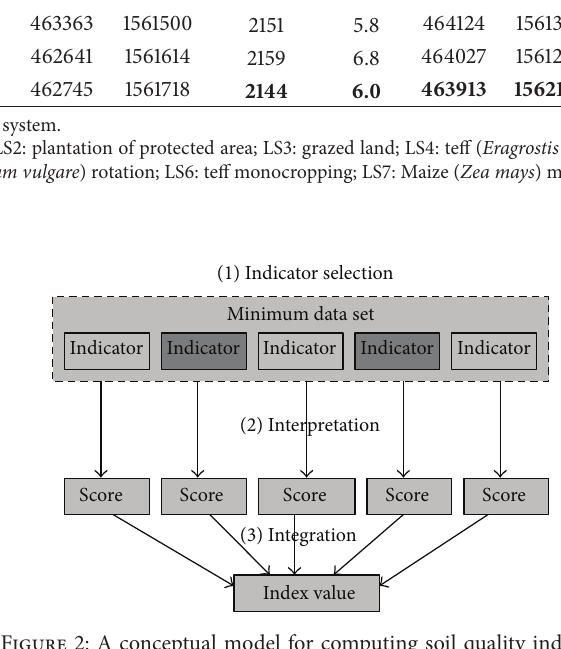
Figure 2: A conceptual model for computing soil quality indices. (From Andrews